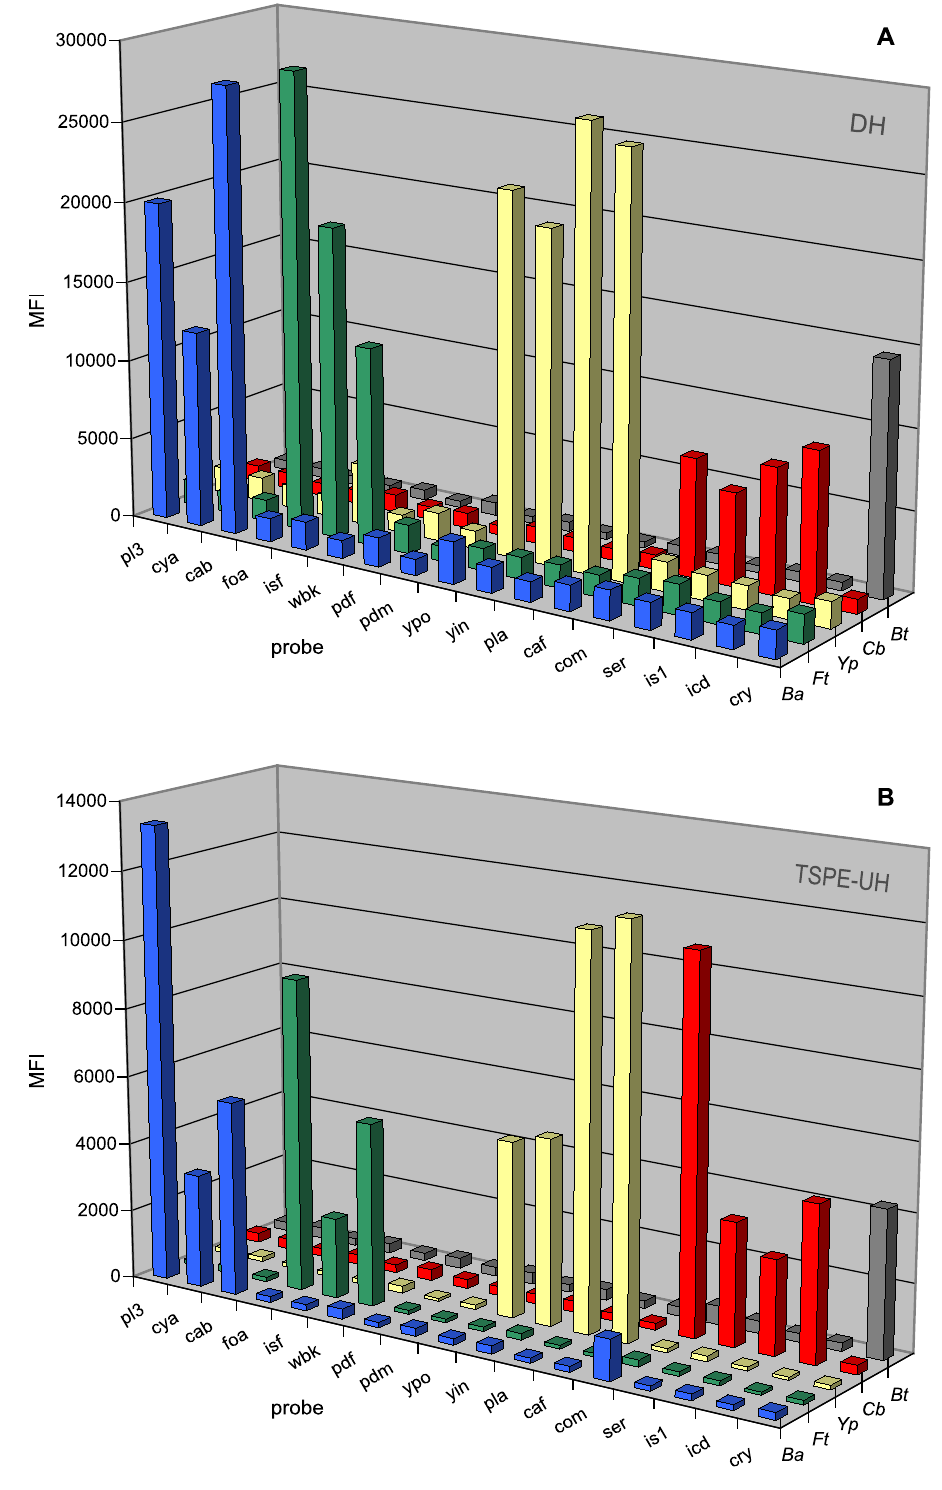
Figure 1. Typical results from DH and TSPE-UH suspension microarrays detecting select pathogens. Two 17-plex bead arrays were developed for the detection of B. anthracis (Ba), F. tularensis (Ft), Y. pestis (Yp), C. burnetii (Cb) and an internal control for DNA extraction and microarray detection (Bt). The microarrays were based on ( A ) direct hybridization (DH), or ( B ) target specific primer extension combined with universal microarray hybridization (TSPE-UH) assay formats. Both microarrays make use of identical amplification products from a 16-plex asymmetric PCR. Mean fluorescence intensity (MFI) is displayed for the different probes that are given in Table 1.